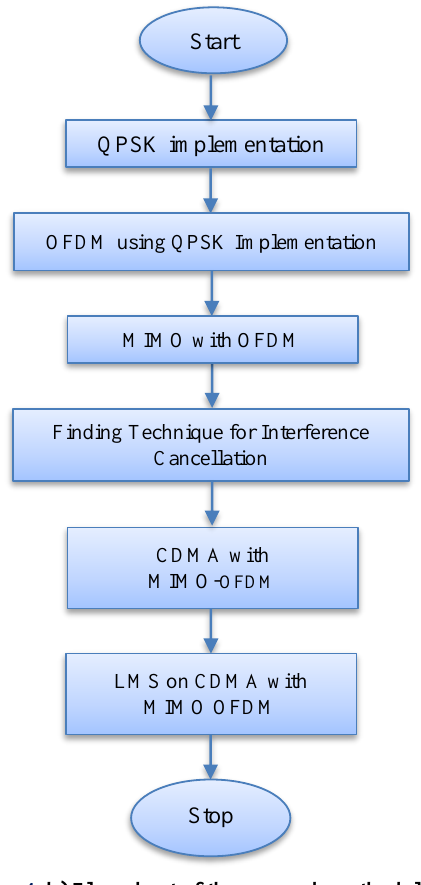
Figure 4. b) Flow chart of the research